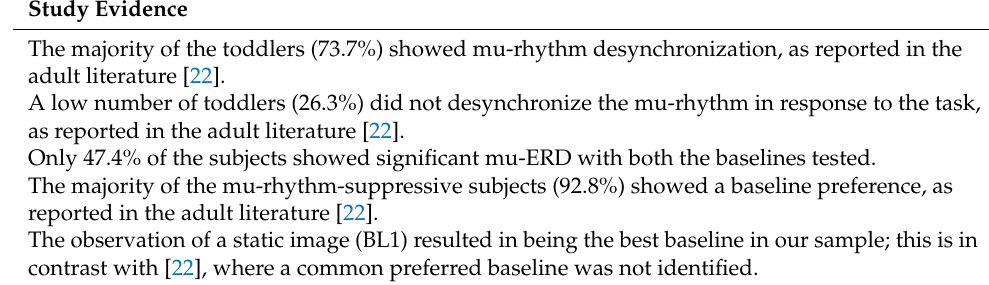
Table 4. Summary of the main findings of the present